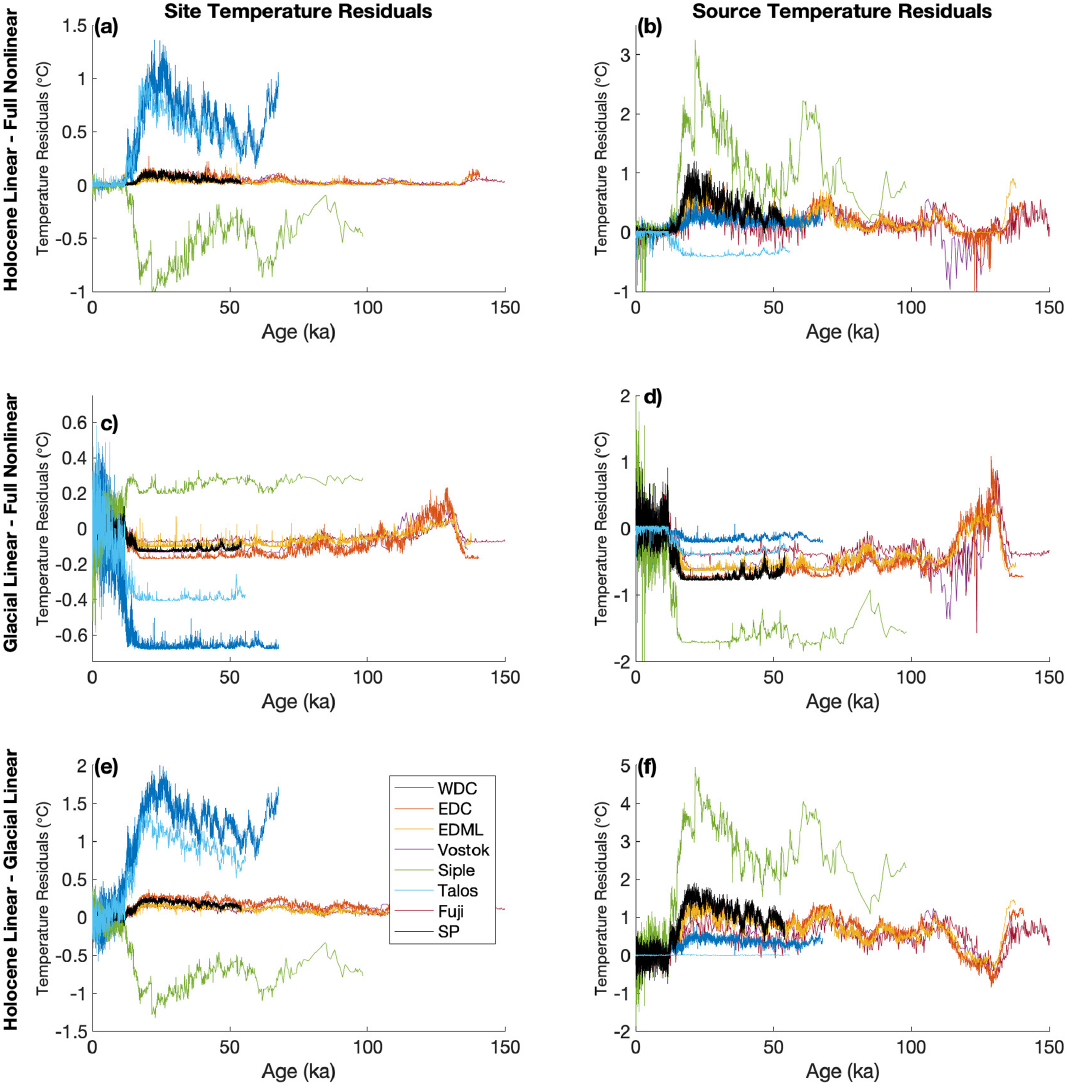
Figure A20. Difference in site surface temperature and evaporation source air temperature using SWIM results and different reconstruction techniques. (a, b) Difference between the nonlinear reconstruction technique and linearization of SWIM results around Holocene conditions. (c, d) Difference between the nonlinear reconstruction technique and linearization of SWIM results around glacial conditions. (e, f) Difference in reconstructions using linearizations of SWIM results around both Holocene and glacial